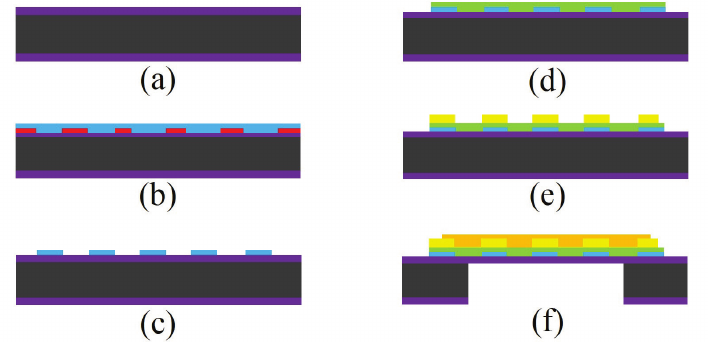
Figure 2. Schematic view of a MOS gas sensor fabrication process ( a ) thermal oxidation of silicon wafer, ( b ) photolithography patterning followed by micro-heater deposition, ( c ) lift-off, ( d ) deposition of a thin SiO 2 layer, ( e ) photolithography and pattern transfer of micro-electrodes followed by lift-off process, ( f ) backside etching and deposition of sensing material on the